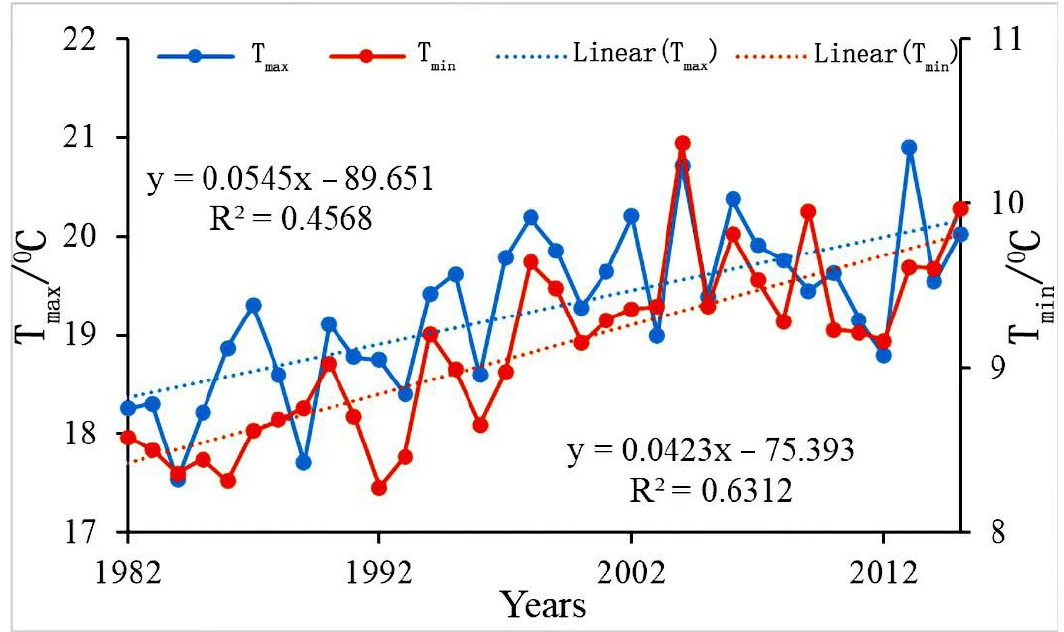
Figure 4. Variation trends of T max and T min in Qinba Mountains from 1982 to